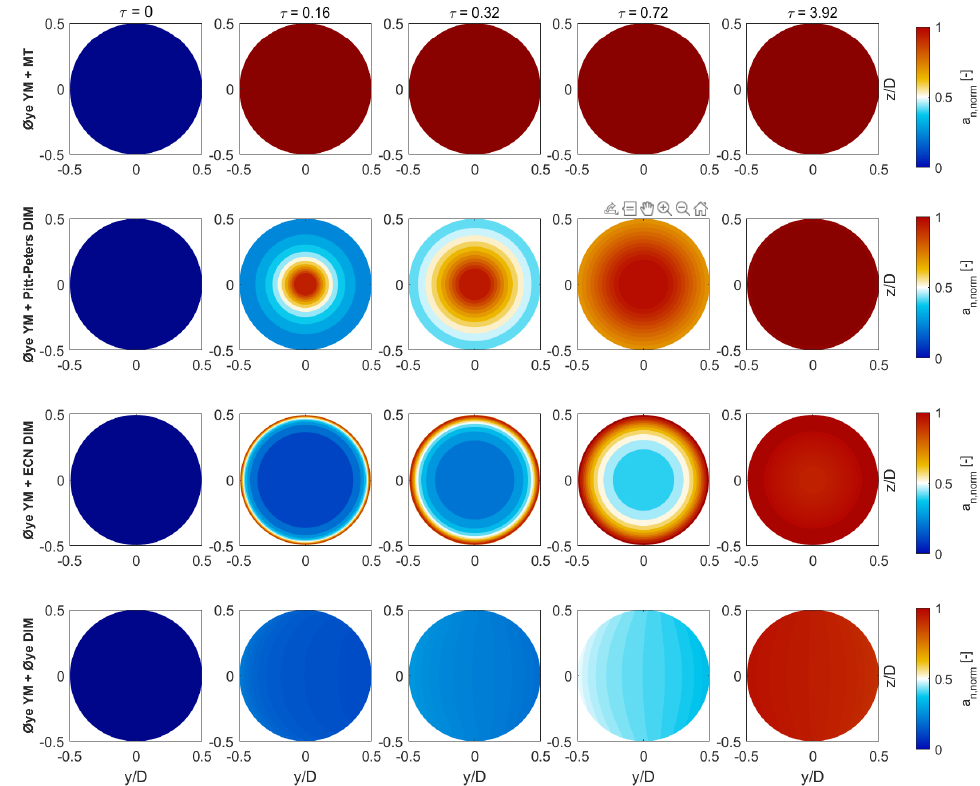
Figure 14. Comparison of normalized induction field a n , norm from different models and τ when base C T = 0.6, step ∆ C T = +0.1, Φ y = 30